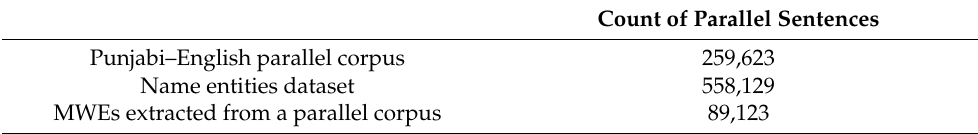
Table 5. The Punjabi–English parallel corpus.